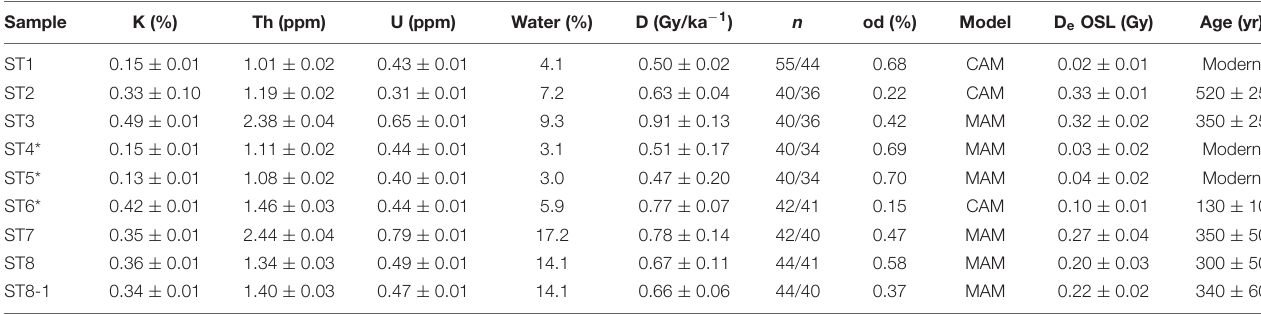
TABLE 1 | Summary data of OSL dating with the concentration of dose-relevant elements (K, Th, and U), measured sediment moisture, total dose rate (D), observed overdispersion, the applied age model (CAM = central age model; MAM = minimum age model), mean D e , and resulting age. Sample K